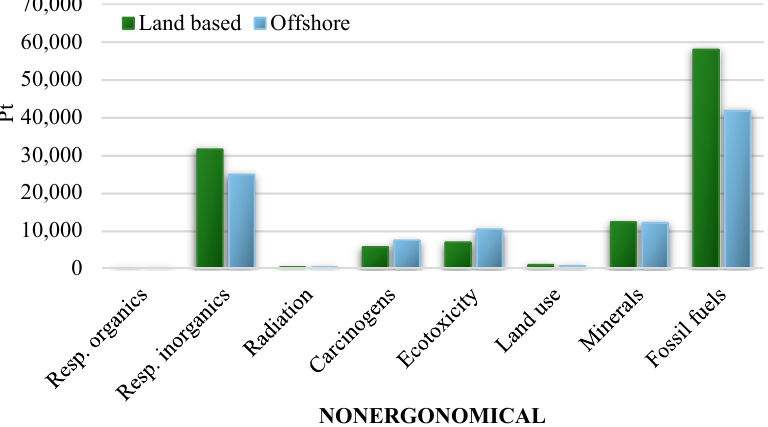
Figure 3. Results of grouping and weighing environmental impacts for ergonomic impacts involved in life cycles of land based and offshore wind farms. Authors’ own research.